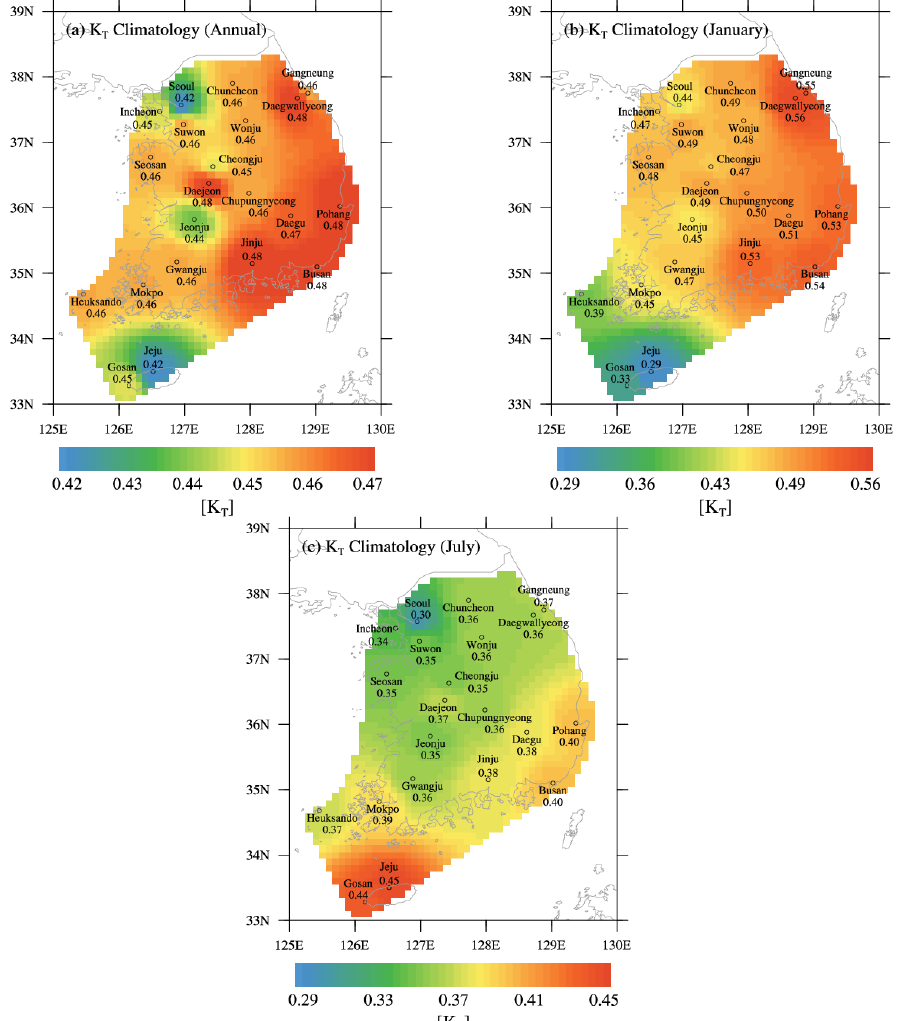
Figure 4. Spatial distributions of K T climatology in Korea: ( a ) annual; ( b ) January; and ( c ) July.